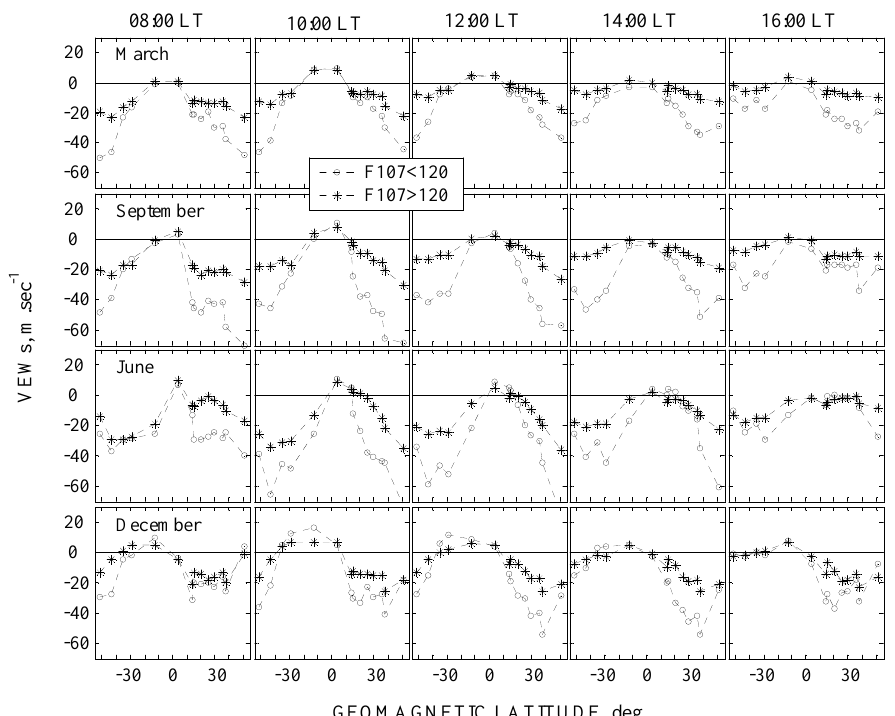
Fig. 4. Same as Fig. 3, but for daytime hours (08:00–16:00 LT). Positive upward.